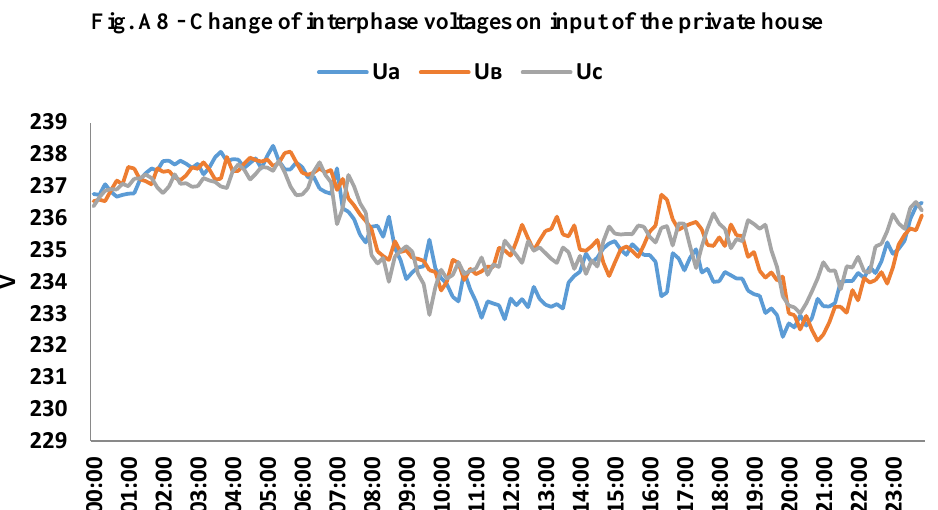
Fig. A9 – Change of phase voltages on input of the apartment